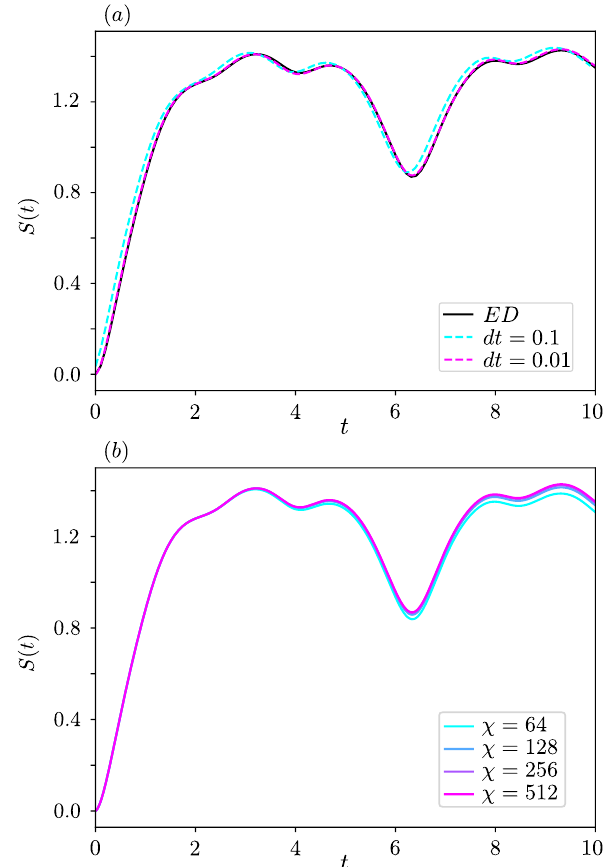
Figure 11: (a) Comparison of the entropy time evolution for L = 10 rungs, obtained by exact diagonalization (black) and TEBD using a first-order Trotter decomposition, with time steps dt = 0.01 and dt = 0.1 (b) Results for L = 64 rungs and dt = 0.01 with different maximal bond dimensions χ